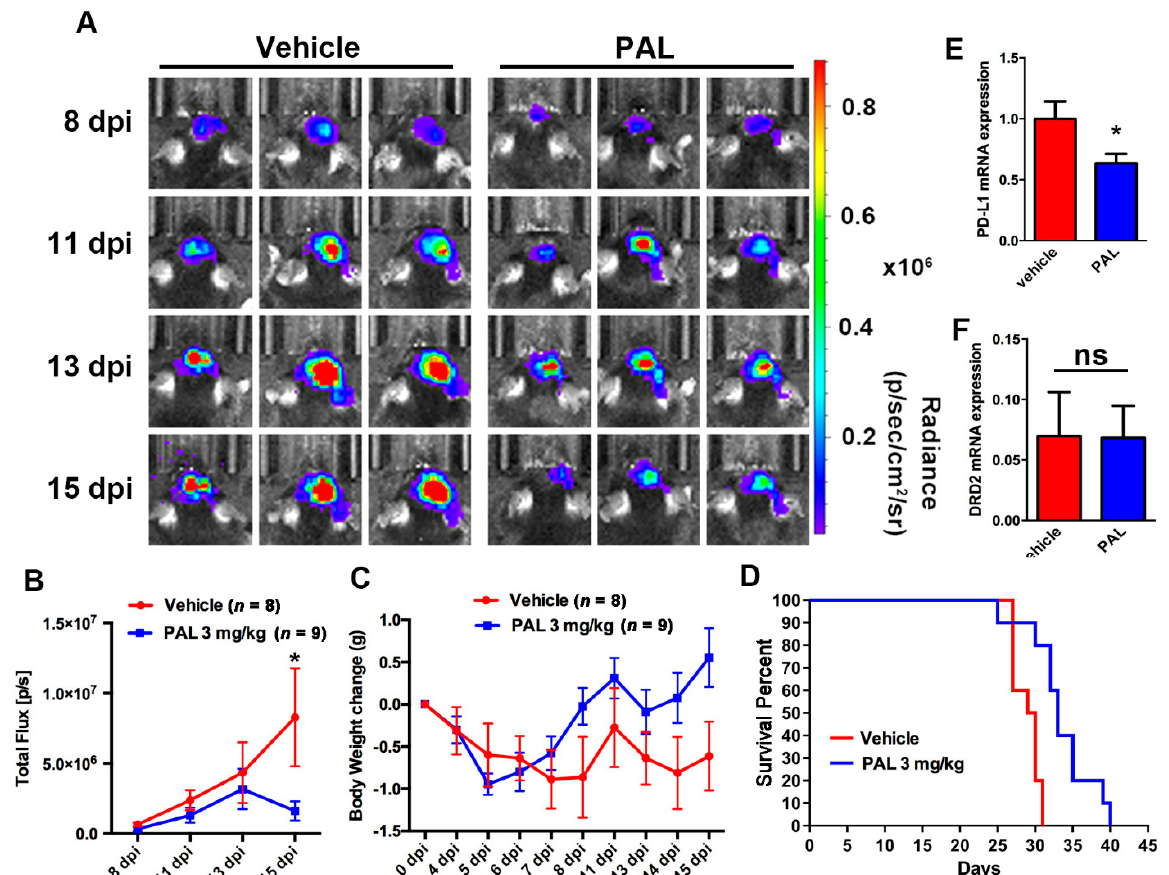
Figure 1. Paliperidone reduces GBM growth and PD-L1 expression and prolongs survival in the intracranial xenograft mouse model. ALTS1C1-luciferase GBM cells were implanted into mice brain, and the mouse was subjected to once daily intraperitoneal injection with paliperidone (PAL; 3 mg/kg) or vehicle. The tumor size was examined at the indicated time points (8, 11, 13, and 15 dpi) by IVIS image. Representative images from each group are shown ( A ). Quantification of tumor size is shown ( B ). The body weight changes are shown in ( C ). ( D ) Kaplan–Meier survival curve showed that mice with treated with paliperidone (PAL; 3 mg/kg) exhibited longer survival than the vehicle group ( p = 0.02). Quantitative data are presented as mean ± SEMs.e.m. Messenger RNA levels of PD-L1 ( E ) and DRD2 ( F ) in the intracranial GBM were examined by real time PCR for day 24. * p < 0.05 compared with the vehicle control (Student’s t-test). Abbreviations: dpi: days post-implantation.